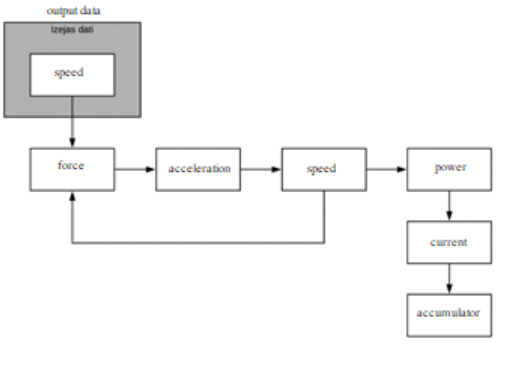
Fig. 1. The proposed algorithm of the model operation.